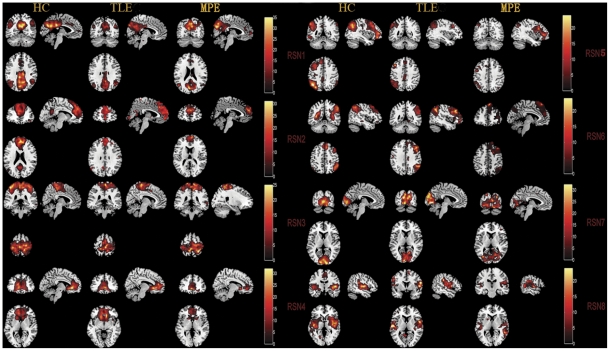
One-sample t-tests results of the eight RSNs in three groups (HC,TLE and MPE).Activated foci are shown with a significance threshold set at P<0.05 (corrected by FDR). The identified networks are labeled as follows: (RSN1) posterior part of the DMN, (RSN2) anterior part of the DMN, (RSN3) sensorimotor network, (RSN4) self-referential network, (RSN5) left lateral frontoparietal network, (RSN6) right lateral frontoparietal network, (RSN7) visual network, (RSN8) auditory network. The left side of the image corresponded to the left side of the brain.